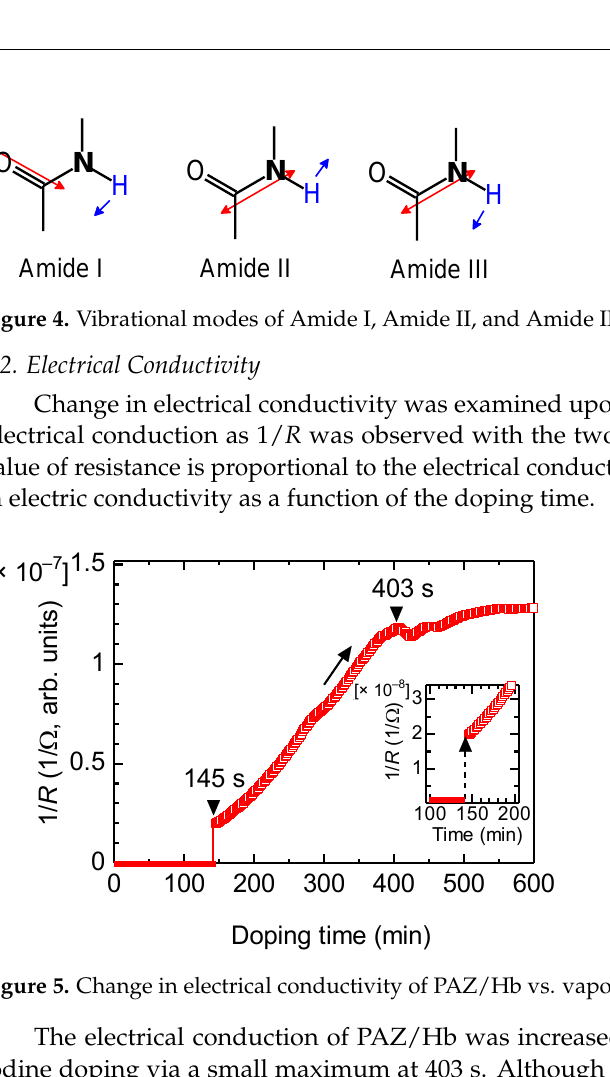
Figure 3. ( a ) Fourier-transform infrared (FT – IR) absorption spectra of hemoglobin (Hb), polyazo- benzene (PAZ), and polyazobenzene/Hb (PAZ/Hb). ( b ) Magnifications of the IR absorption spectra.